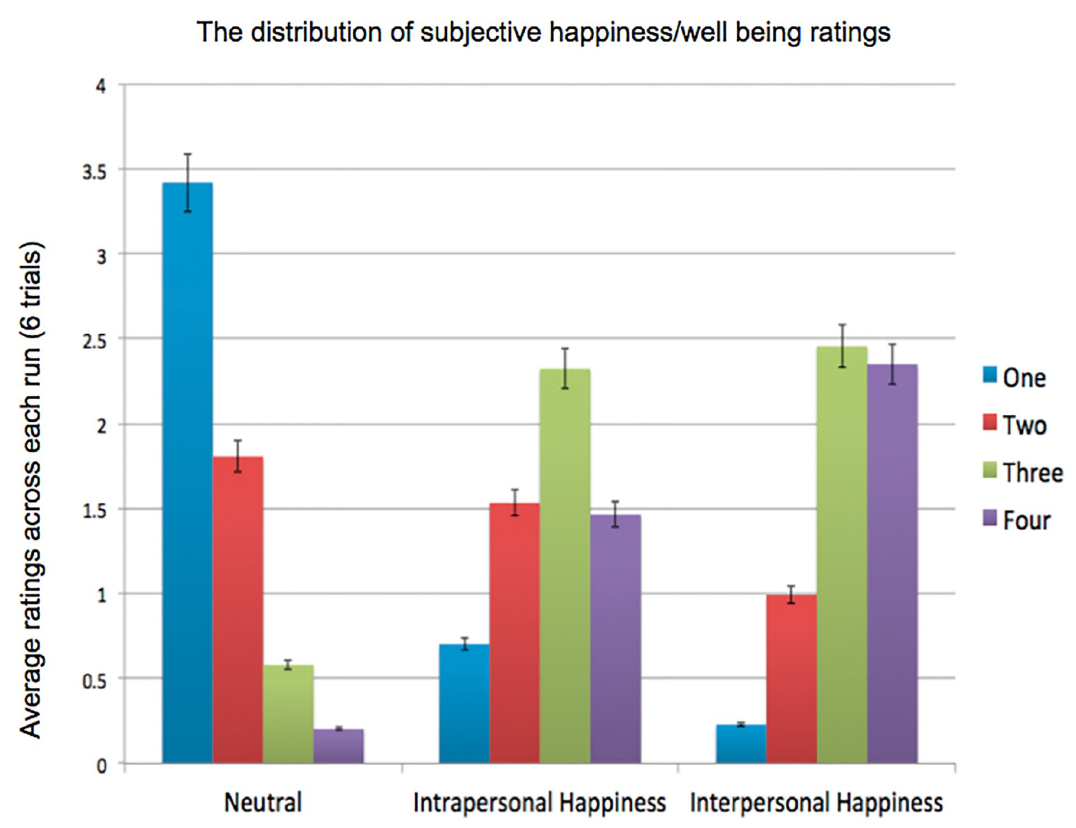
Fig 2. The distribution of subjective happiness/wellbeing ratings for each condition. 1 to 4 denotes the strength of happiness feeling invoked by the individual figure, and emphasized on how each picture make them feel, not evaluating on the people in the pictures. The average happiness ratings were as follows: Interpersonal (3.06) > Intrapersonal (2.69) > Neutral (1.56)